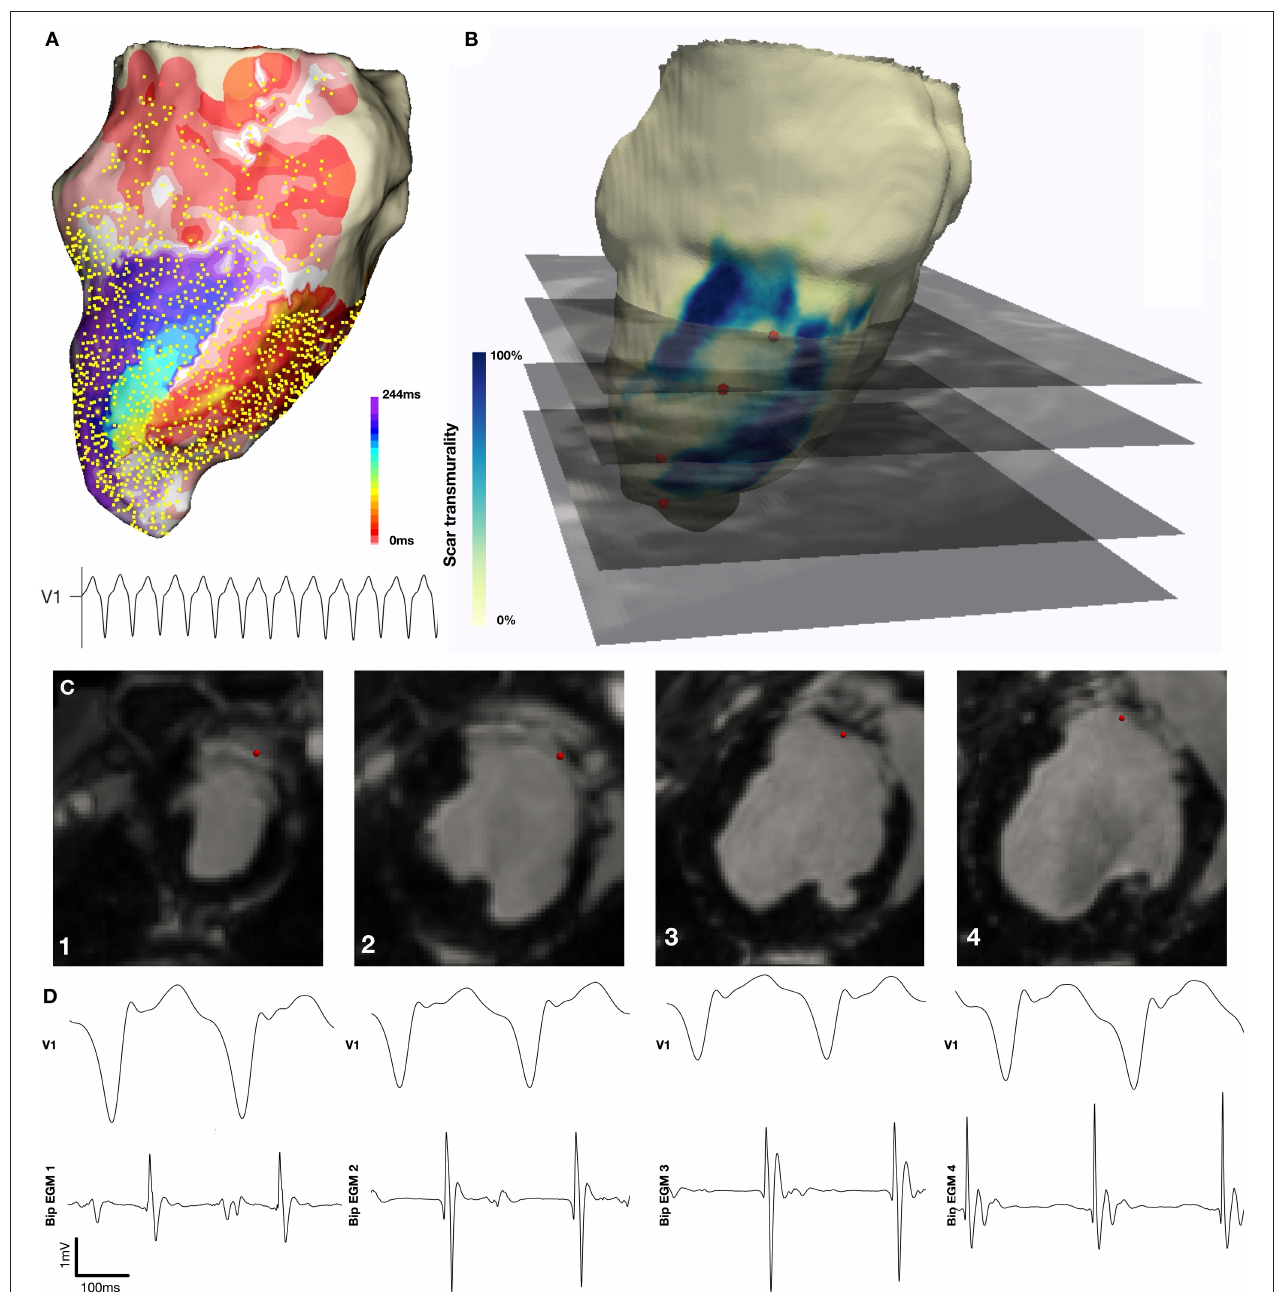
FIGURE 4 | Localization of diastolic locations on in-vivo CMR imaging. (A) Activation map demonstrating re-entrant VT with a figure 8 pattern of re-entry. (B) CMR derived mesh color coded according to scar transmurality with location of selected diastolic EGMs indicated by red sphere and corresponding in-vivo LGE CMR imaging indicated. (C) Diastolic EGM and corresponding location on in-vivo CMR at four sequential points along the diastolic isthmus of this